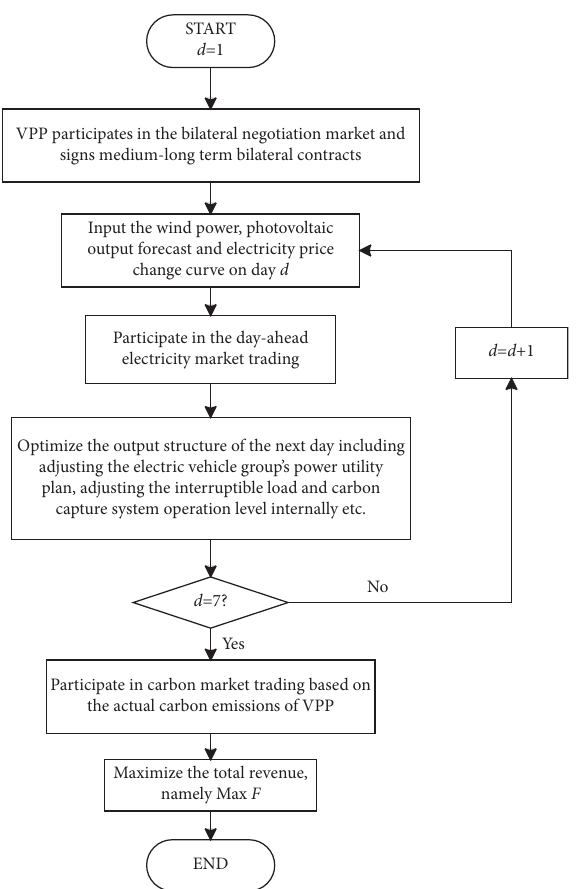
Figure 1: Virtual power plant electricity-carbon joint trading